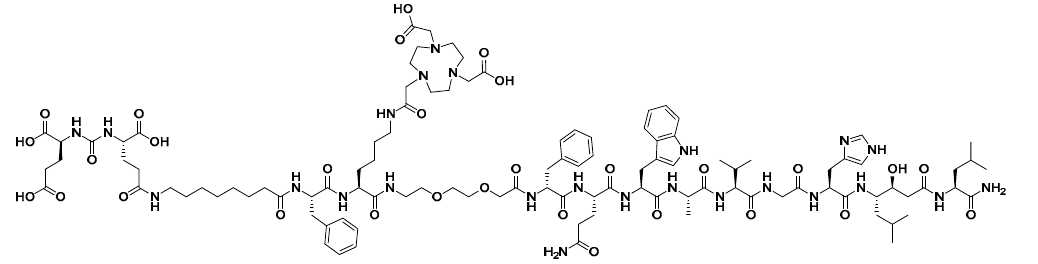
Figure 1. Chemical structure of the PSMA/GRPR-targeting heterodimeric radiotracer